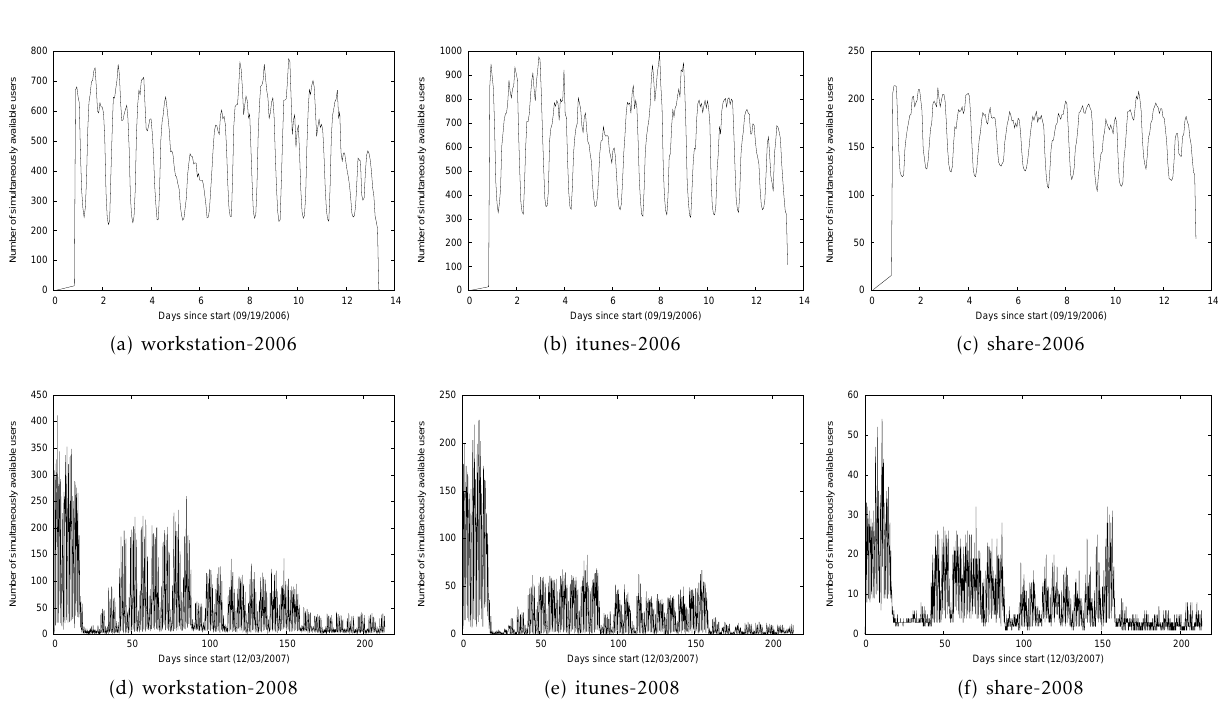
Figure 1. Number of simultaneously available campus users